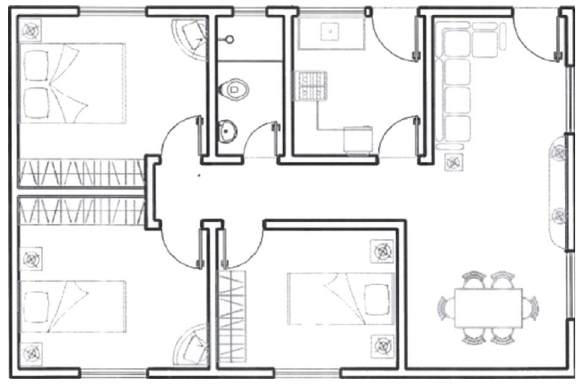
Figure 15: Real floor